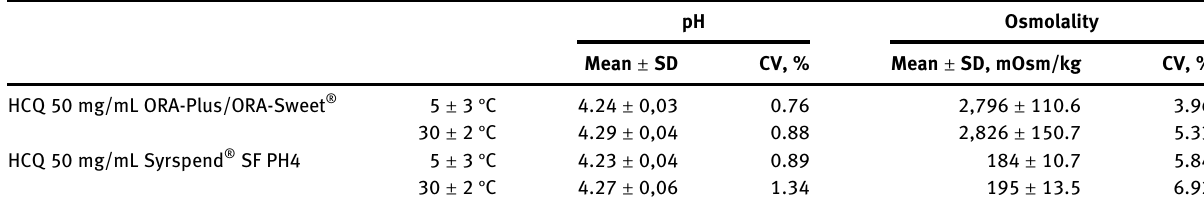
Table  : Mean of pH and osmolality of eight measures during  days of each HCQ suspension in different storage conditions.